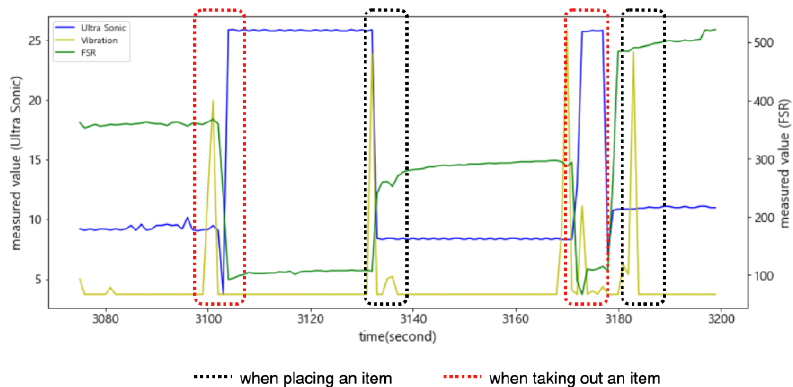
Figure 20. Determination of the state of the door ( 𝑠𝑡𝑎𝑡𝑒 𝑑𝑜𝑜𝑟 ) of the smart storage.